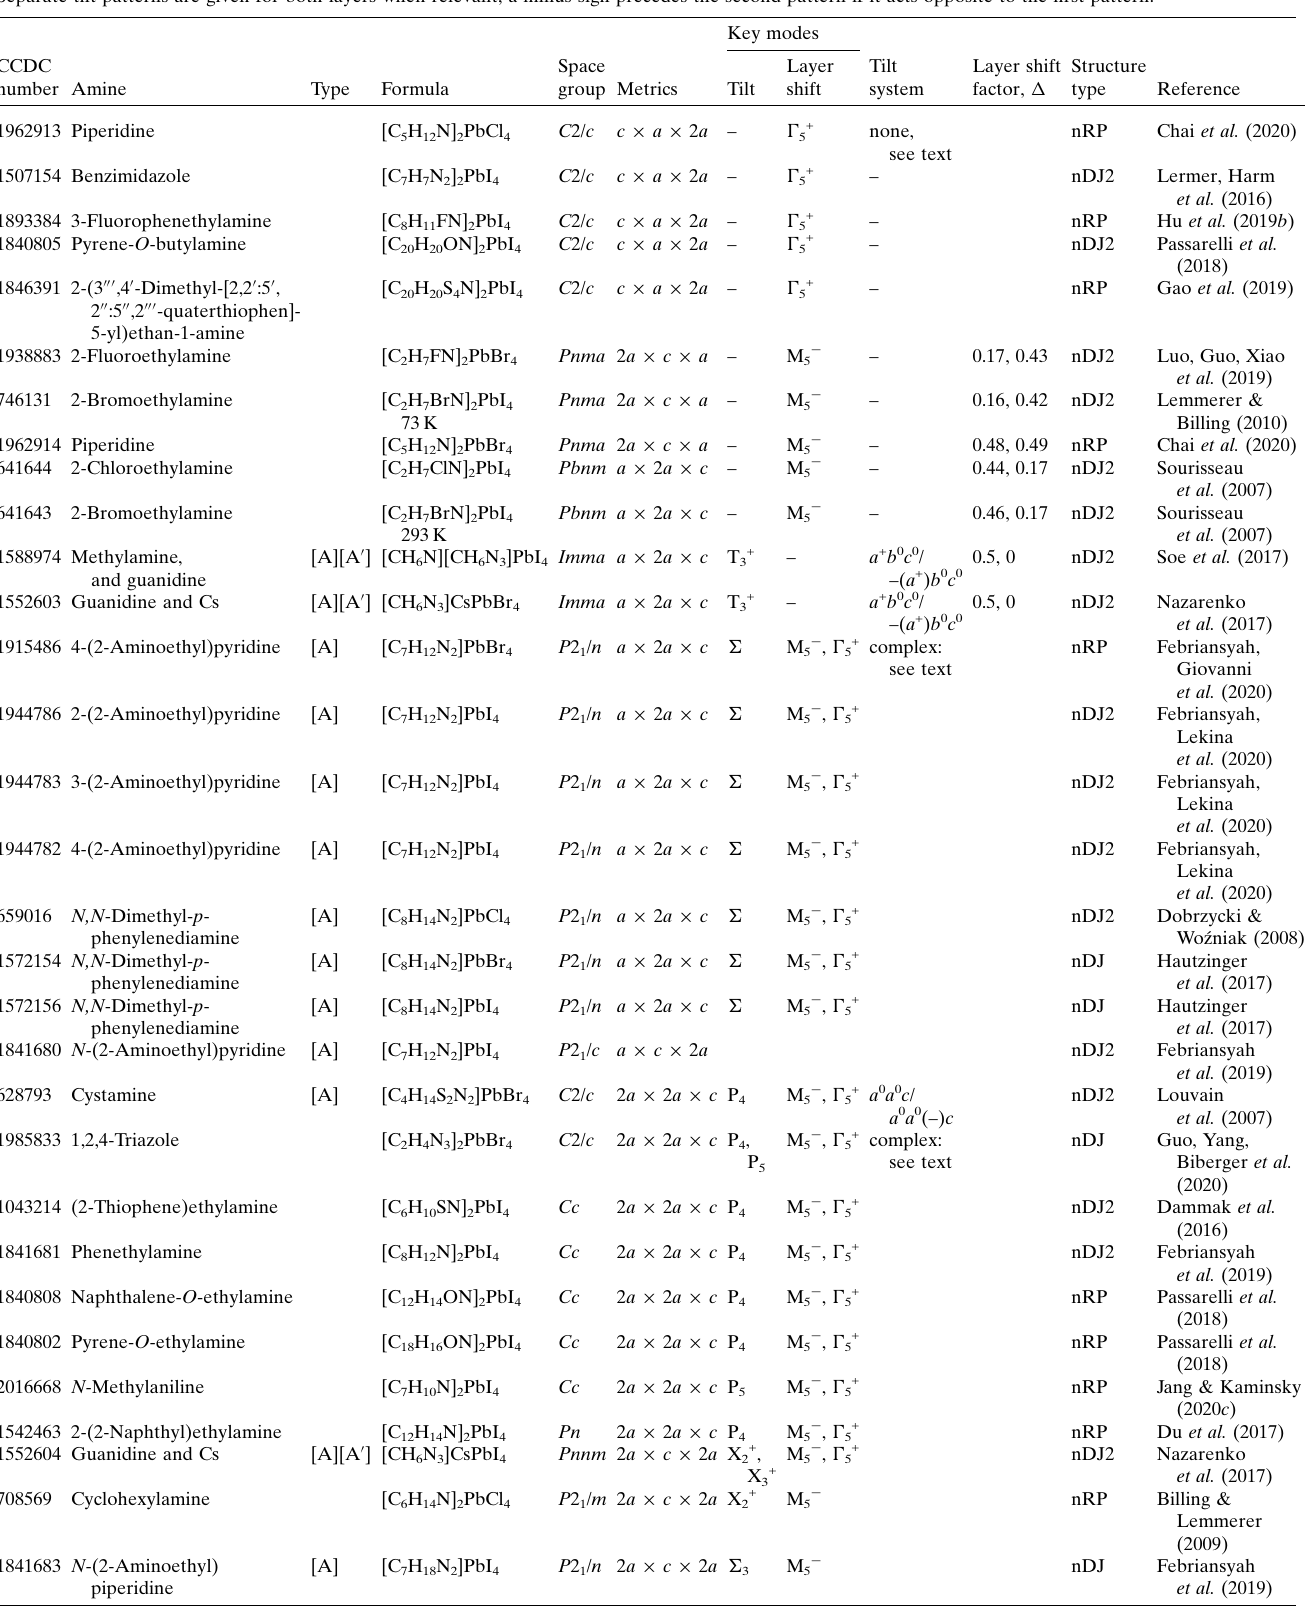
Table 3 Experimental structures with two octahedral layers per unit cell (derived from RP parent, I 4/ mmm ) and at least one axis in the layer plane doubled. Separate tilt patterns are given for both layers when relevant; a minus sign precedes the second pattern if it acts opposite to the first